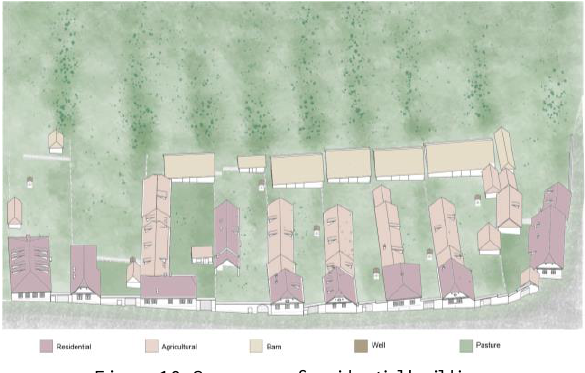
Figure 10. Sequence of residential buildings in the village of Viscri.